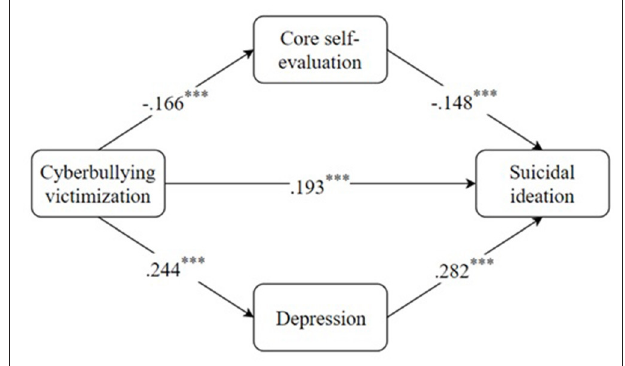
FIGURE 2 | Standardized path coefficients for the pararlel mediation model. *** P < 0.001.